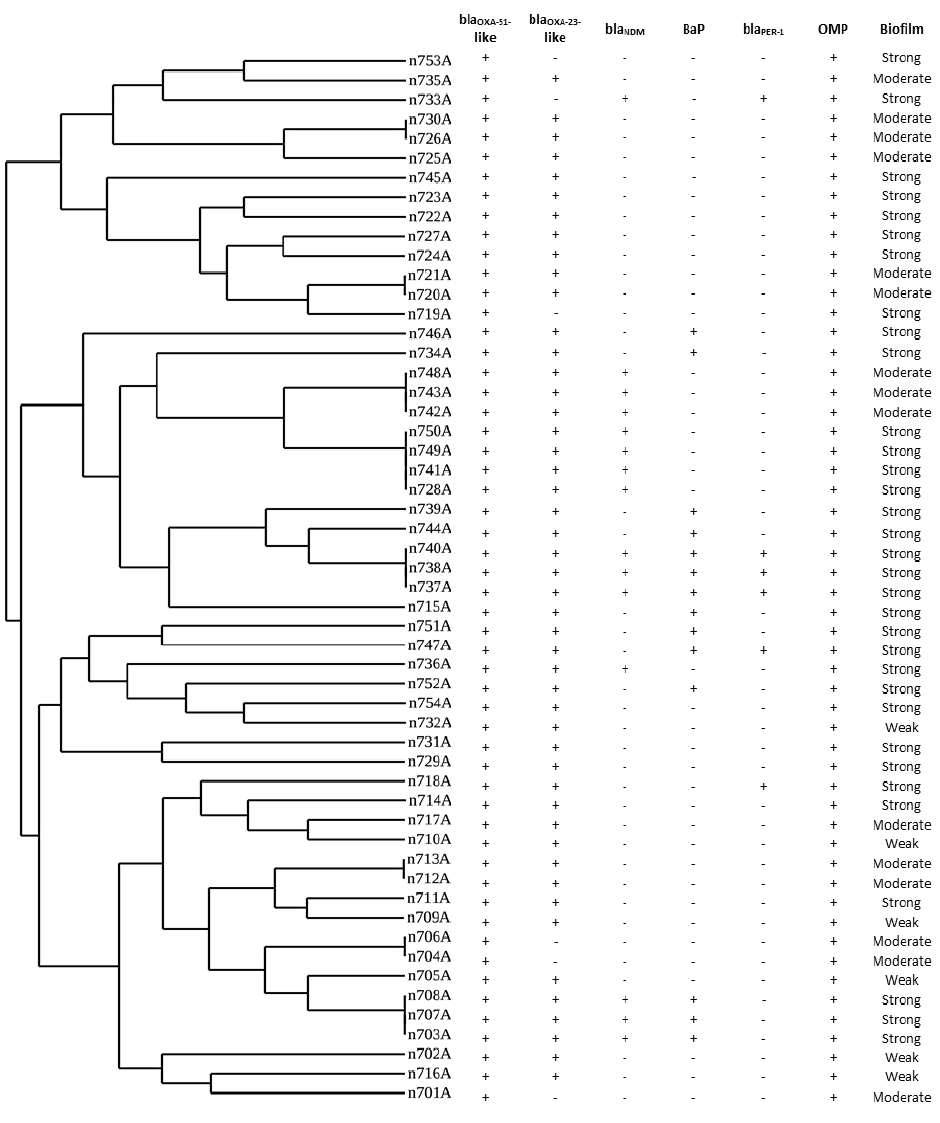
Figure 1. Dendrogram analysis of repetitive element palindromic (REP)-PCR genotyping of carbapenem-resistant Acinetobacter baumannii (CRAB) isolates. Clusters homology of isolates was designed by the Uviband map based on the unweighted pair group method using the arithmetic averages algorithm